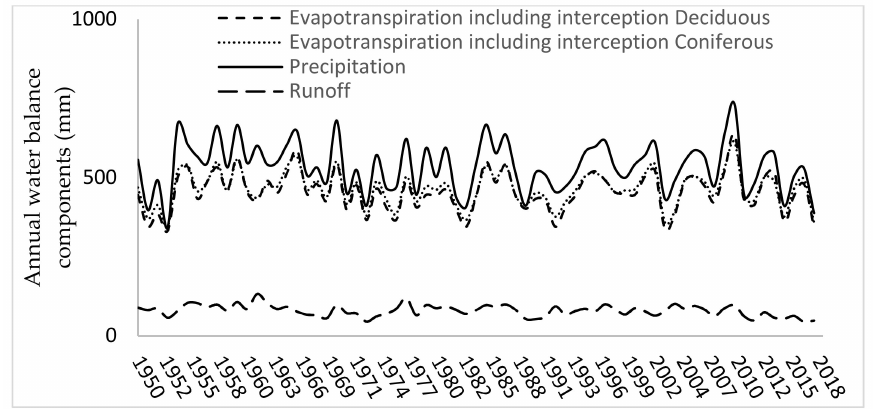
Figure 5. Annual modelled water balance components since 1950. The solid line represents an- nual precipitation while the lower line shows annual streamflow. Dashed and dotted lines show evapotranspiration of deciduous and coniferous stands, respectively.